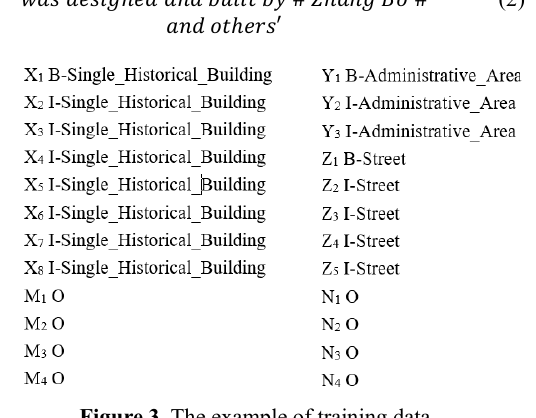
Figure 3 . The example of training data